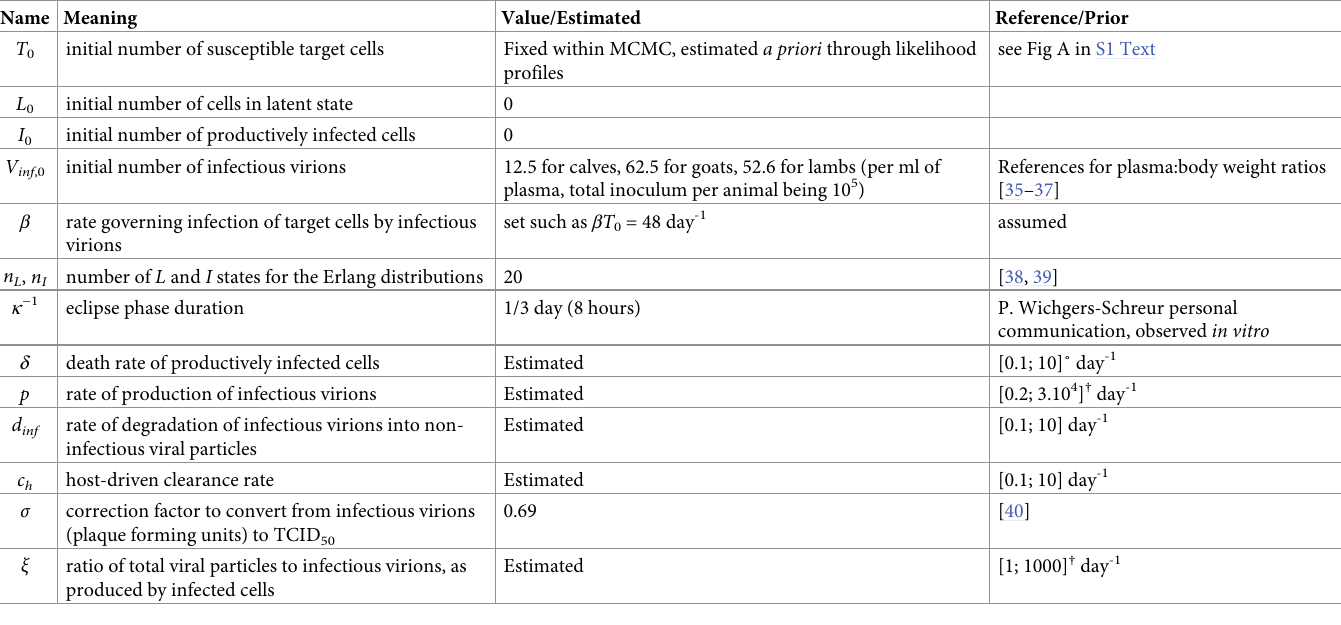
Table 1. Parameters of the within-host model. Values if fixed, prior range (uniform distribution) if